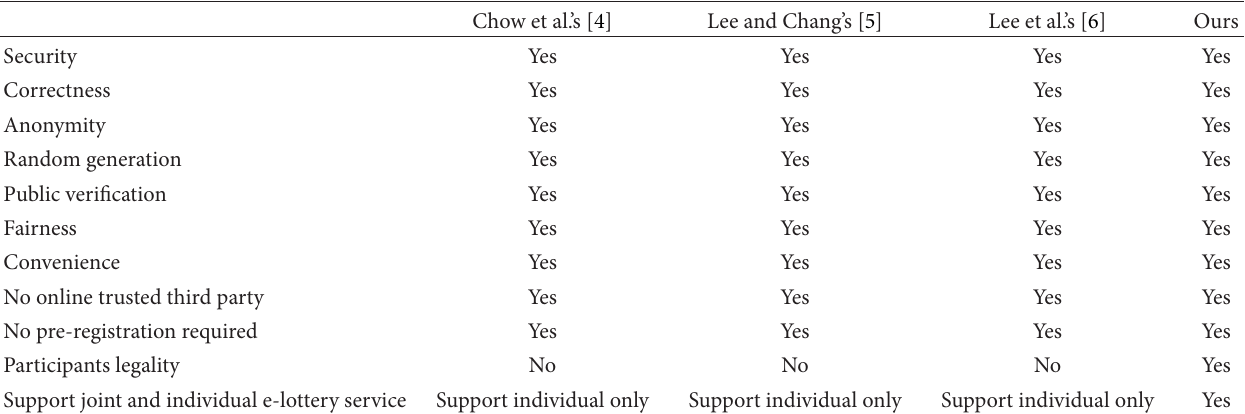
Table 2: Comparisons between related works and ours.